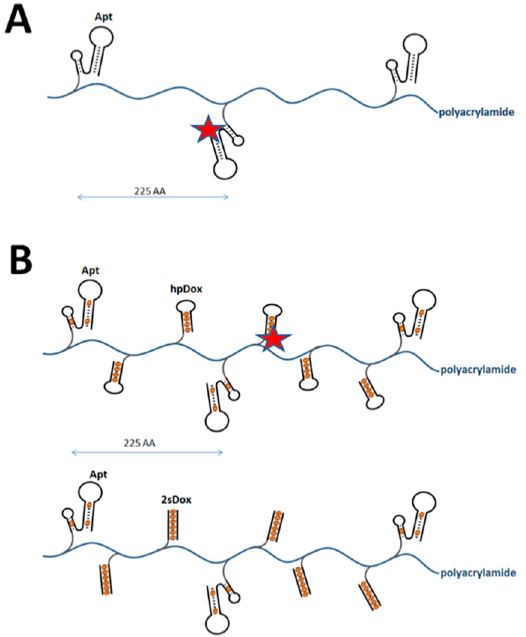
Figure 5. ( A ) Schematic of truncated SKBR3-R1 (Apt) co-polymerized with acrylamide. Spacing between each aptamer is ~225 acrylamide monomers and one in every five aptamers is labeled with Alexa Fluor 594 (red star). ( B ) Schematic of truncated SKBR3-R1 (Apt) co-polymerized with hairpin Dox Boxes (hpDox) or 2-strand Dox boxes (2sDox) and acrylamide in a ratio 1:2.5:225. In the case of the hairpin Dox boxes, one in every 10 Dox boxes is labeled with Alexa Fluor 594 (red star). Dox is indicated as orange ovals.